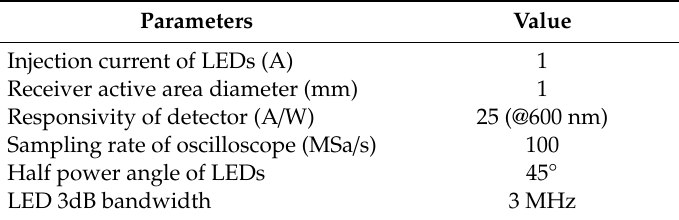
Figure 4. ( a ) Experimental setup of positioning system, ( b ) LED transmitter. Table 1. Specific Parameters of Positioning System.